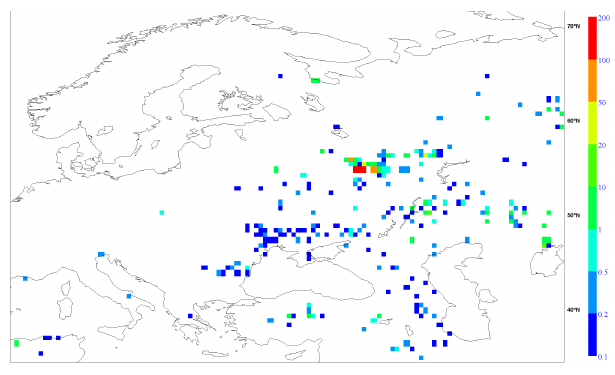
Fig. 11. GFASv1.0 combustion rate [g ( C ) m − 2 d − 1 ] on 4 August